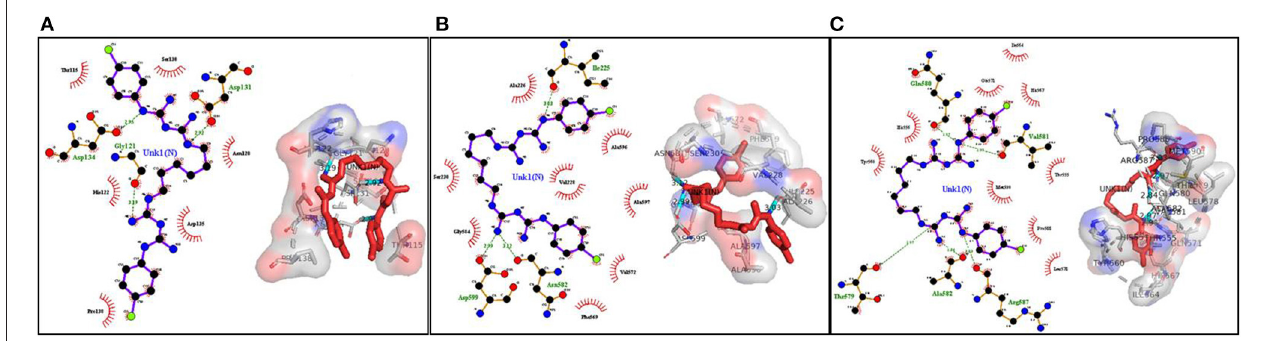
FIGURE 1 | Molecular docking of CHG with proteins of S. parasitica. (A) with S. parasitica host targeting protein, (B) with plasma membrane ATPase, (C) with TKL protein kinase.